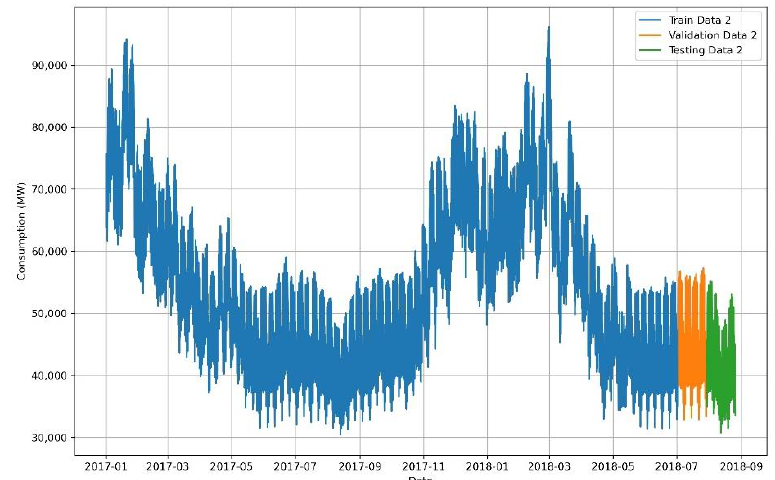
Figure 5. Power consumption for the data division 2.